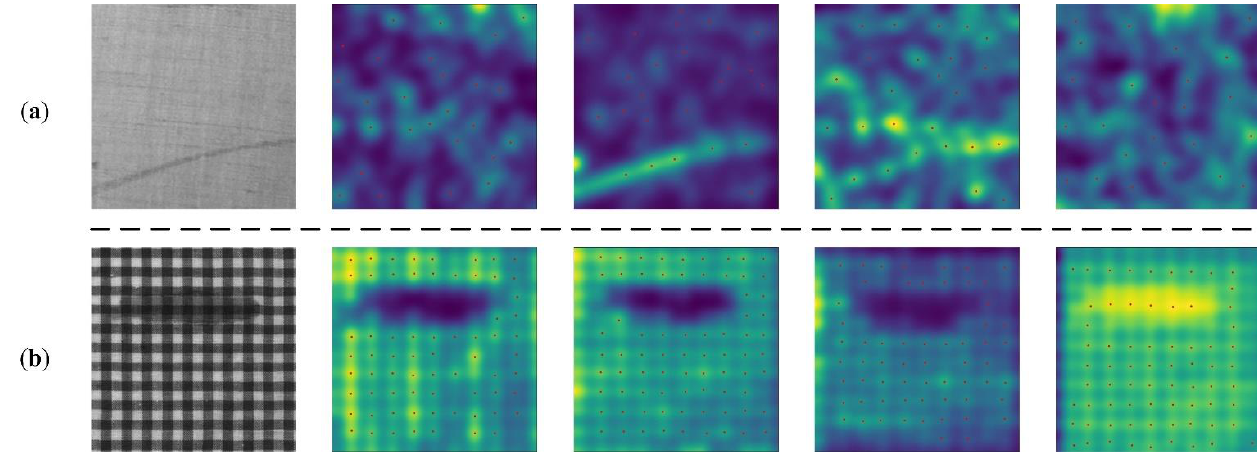
Figure 9. Peak activation of feature maps in random layers in the repeated pattern analysis network. ( a ) is from a repeated-pattern-free fabric image, ( b ) is the contrast response result of a repeated-pattern image.